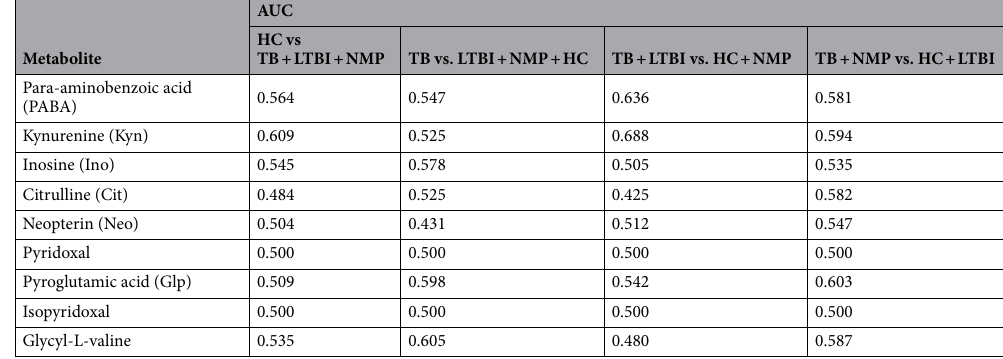
Table 5. Results of the ROC analyses of metabolites measured in M.tb -stimulated whole blood QFT cultures. AUC area under curve, HC M.tb-uninfected healthy controls, LTBI latently M.tb infected individuals, NMP patients with nonmycobacterial pneumonia, TB active tuberculosis